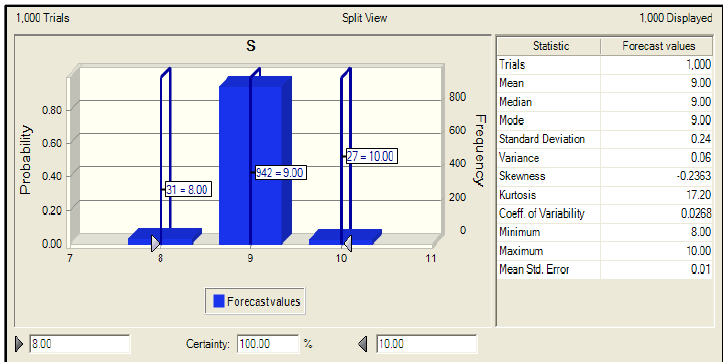
Figure 15. Case 2: Monte Carlo simulation of S in CB software.